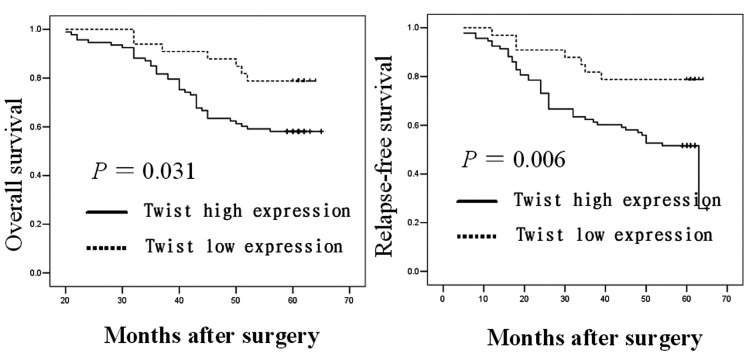
Correlation between Twist protein expression and overall survival (OS) and relapse-free survival (RFS) in breast cancer patients.